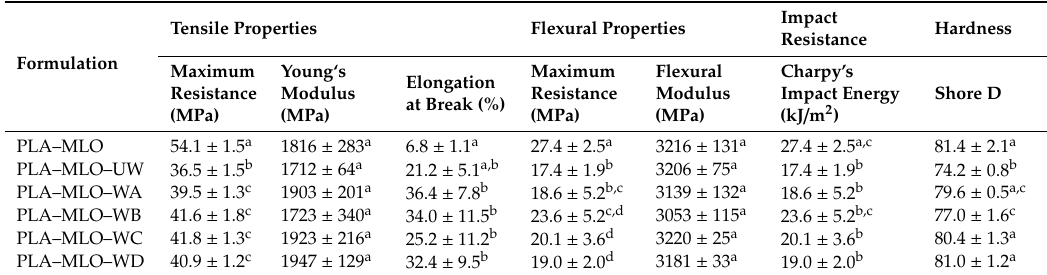
Table 1. Tensile, flexural, hardness and impact resistance properties of poly(lactic acid) (PLA–)–wool fiber reinforced polymer